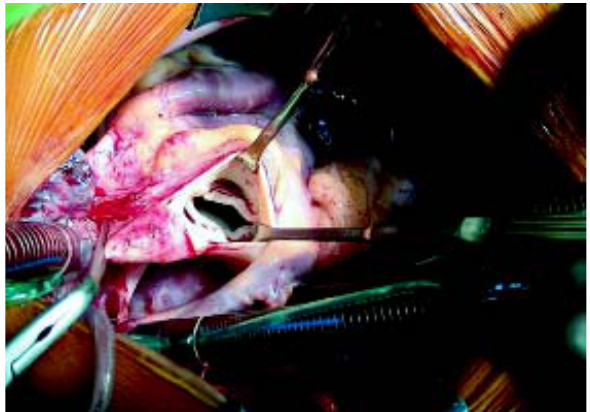
Fig. 2 - Aspecto da valva aórtica acometida pela doença